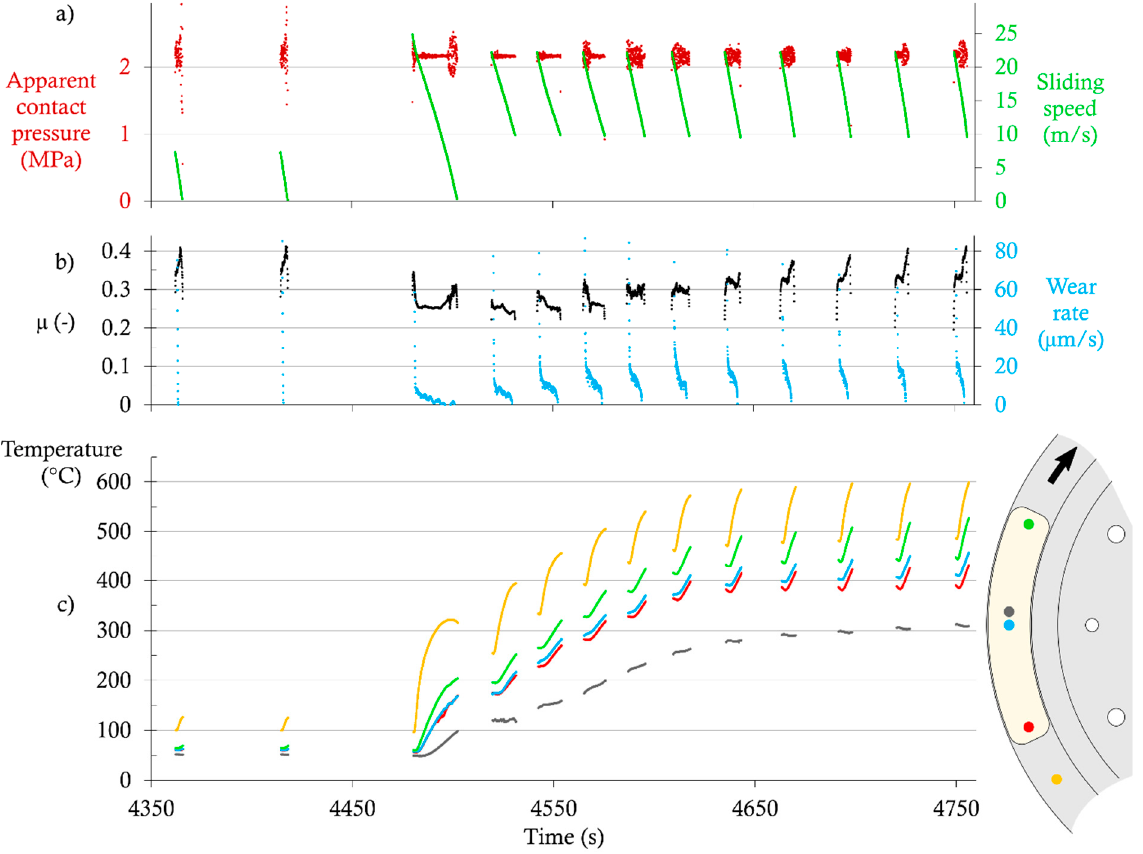
Figure 7. Extract of test data for the LS-GCI configuration: ( a ) Apparent contact pressure and sliding speed; ( b ) coefficient of friction (CoF) and wear rate; ( c ) disc and pad temperatures.